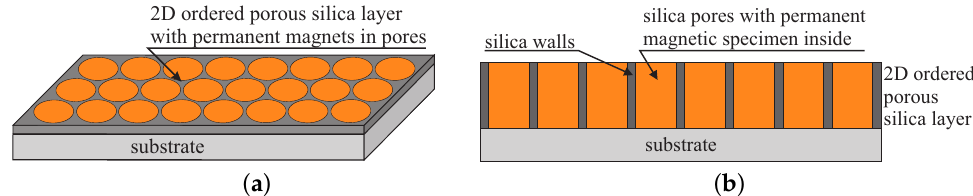
Figure 14. The structure of the silica-based memory storage device: perspective projection ( a ); and cross section ( b